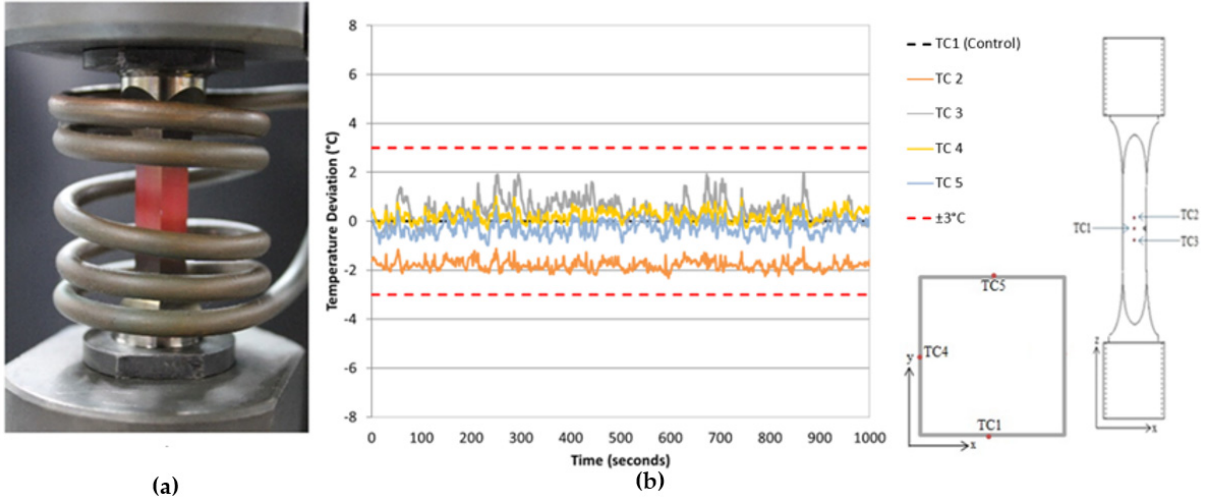
Figure 2. ( a ) Non-uniform multi-turn longitudinal helical coil ( b ) Temperature distribution associ- ated with non-uniform multi-turn longitudinal field helical coil, showing a spread of ±3 °C in temperature across the critical volume of material around the crack and TC location, where TC2 and TC3 have been placed at ±5 mm from TC1, respectively, and TC4 and TC5 are placed to show effects at 90° and 180°, respectively [13]